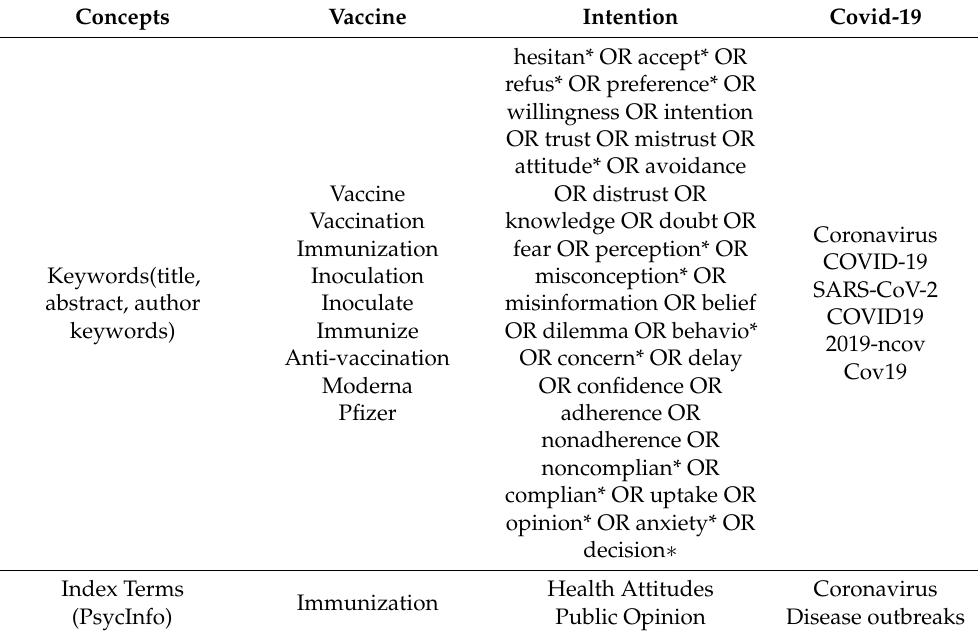
Table A3. PsycINFO search